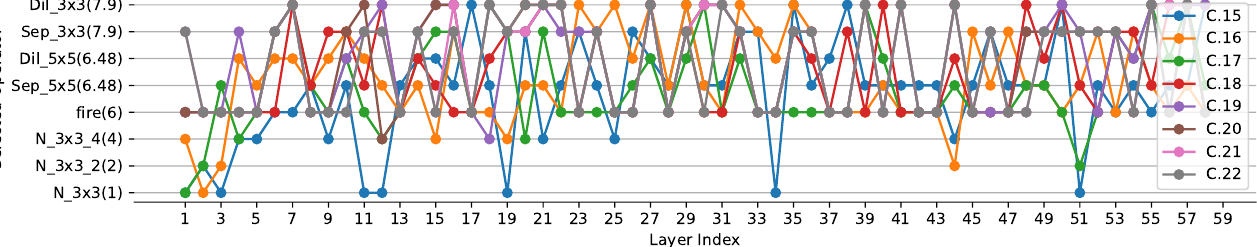
Figure A2. The operator of each layer in compressed DenseNet121. The layers in the figure do not include the first convolutional layer and the last fully connected layer. The vertical axis has the same meanings as Figure 5.